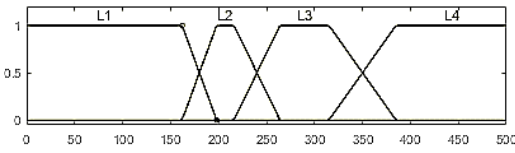
Figure 9. Input membership functions for H 2 . Figure 10. Input membership functions for CH 4 .